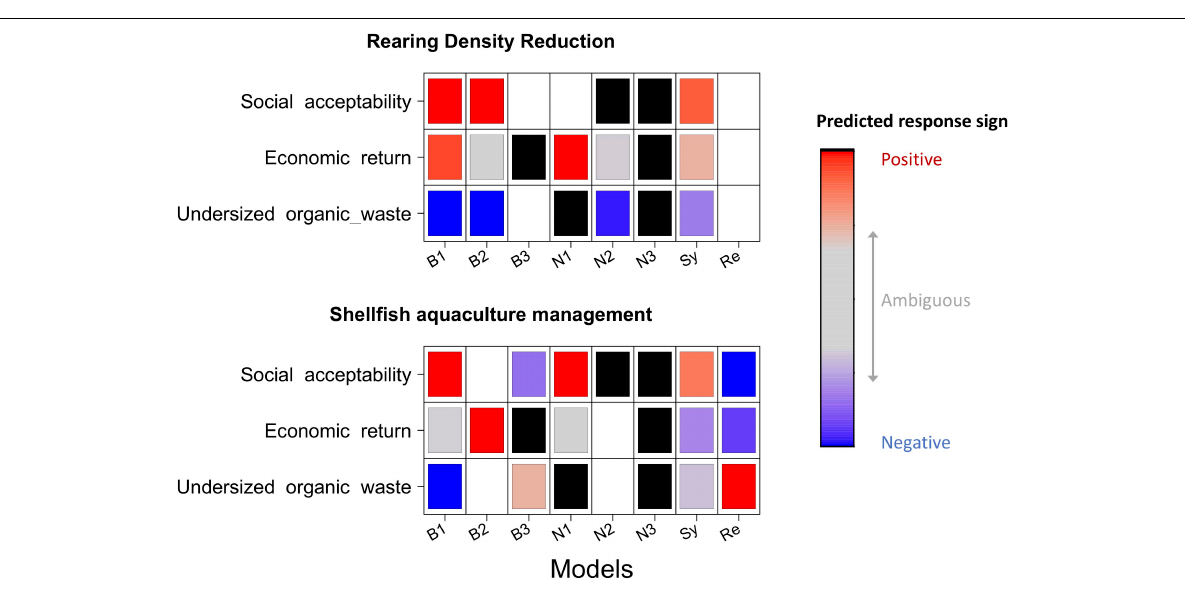
FIGURE 6 | Predicted qualitative responses of variables ( y -axis) to a decrease in rearing stock density (top) and to an improvement in management of shellfish aquaculture practices (bottom) according to the eight models ( x -axis). “Sy” corresponds to the synthetic model, and “Re” to the researcher model. Legend: colored squares represent the sign of response of each variable ( y -axis) to a given scenario ( x -axis): white for neutral (no effect of the scenario on response variable); gray for ambiguous; red for positive; blue for negative. When responses are positive or negative, the degree of shading increases with prediction uncertainty. Black squares correspond to the absence of the scenario variable or/and of the response (i.e., impacted) variable in a given